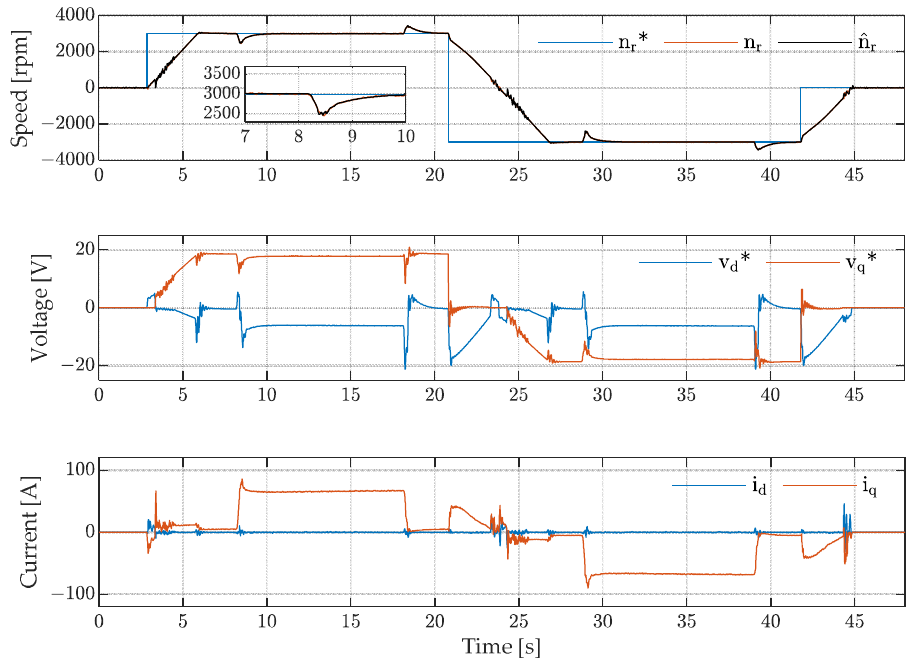
Figure 30. Ramp-up and ramp-down with the nominal reference speed and 100% load applied at steady-state: speed, dq voltages, dq currents.